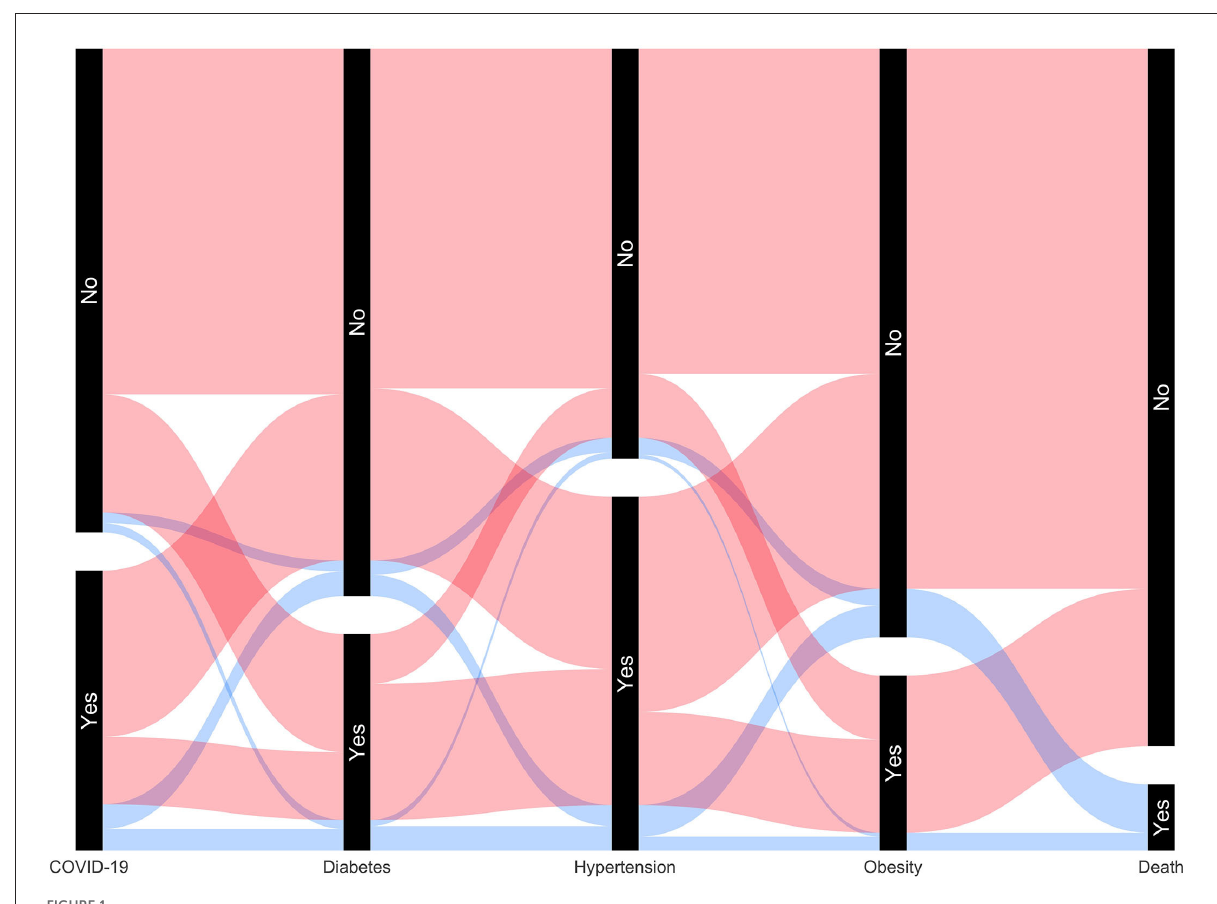
FIGURE1 Parallel set visualization of the total number of patients with COVID-19 and other comorbidities, including death.